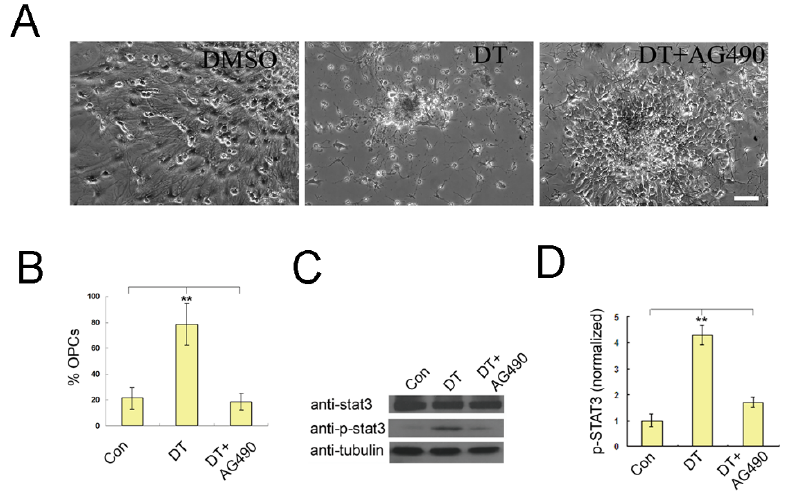
Figure 6. JAK2/STATA3 signaling is involved in DT-induced NSC differentiation into OPCs. Typical cell morphology of NSCs treated with DMSO, DT and DT+AG490 under a phase contrast microscope after 5 days of culture, Scale bar = 50 μ m ( A ). JAK2 inhibitor AG490 treatment completely reversed the DT-induced OPC differentiation, indicating the involvement of the JAK2/STAT3 signaling, **, p < 0.01 by Student’s t -test ( A , B ). Western blot revealed that DT significantly stimulated the phosphorylation of STAT3 and increased the expression of olig2, while AG490 inhibited these effects, **, p < 0.01 by Student’s t -test ( C , D ).